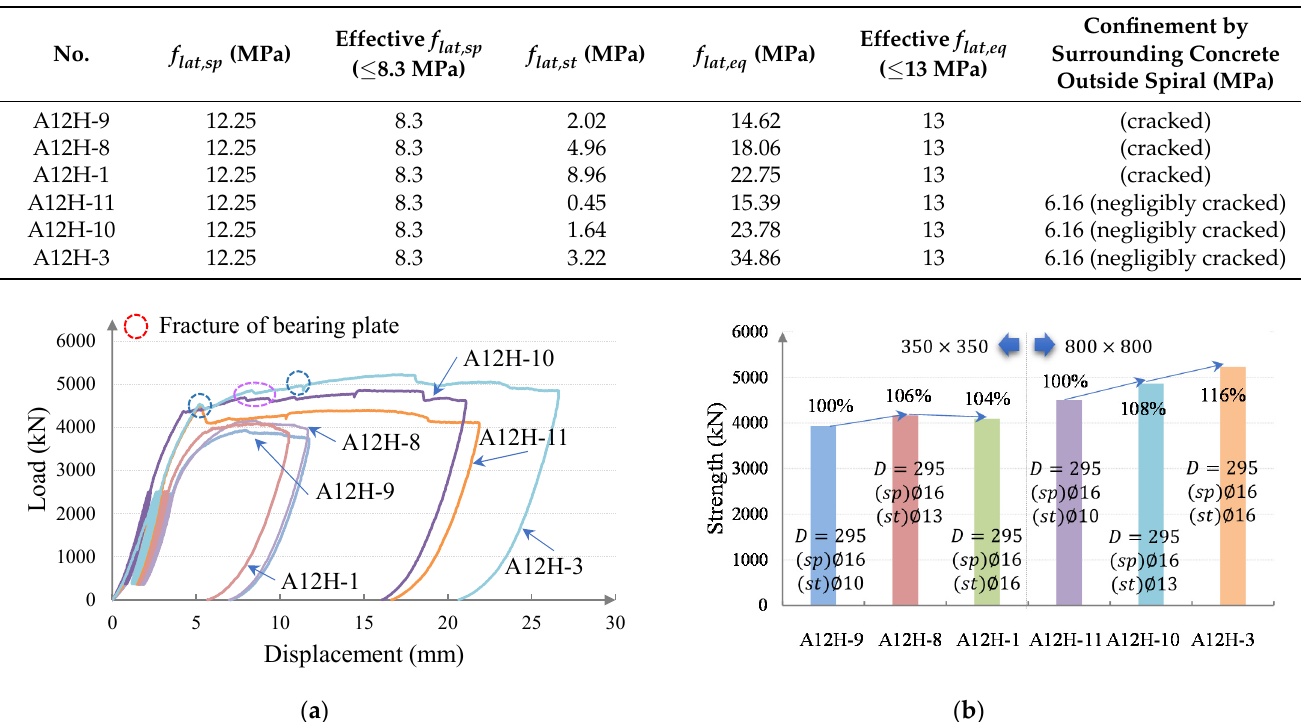
Table 5. Lateral confinement of group 3 specimens.